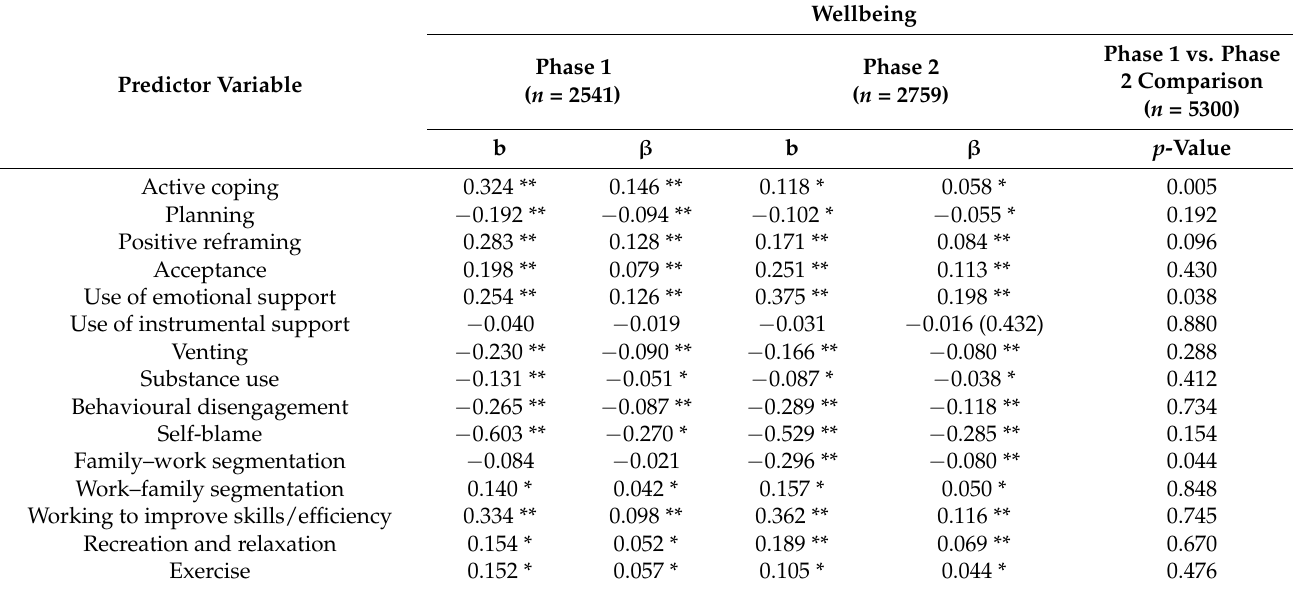
Table 3. Multiple group regression analysis examining coping strategies as predictors of wellbeing.